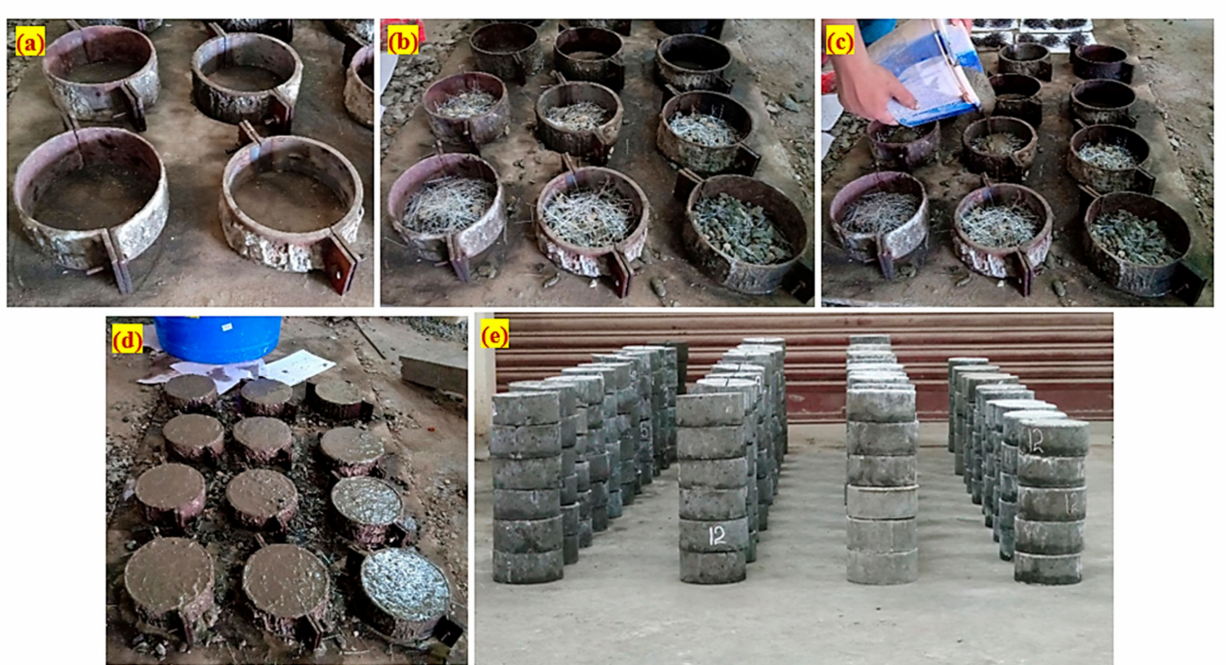
Figure 7. Casting procedure: ( a ) empty mold, ( b ) filling the mold with premixed fibers and coarse aggregate, ( c ) grout pouring process, ( d ) specimen appearance after casting, and ( e ) after demolding, where the specimens were left on the